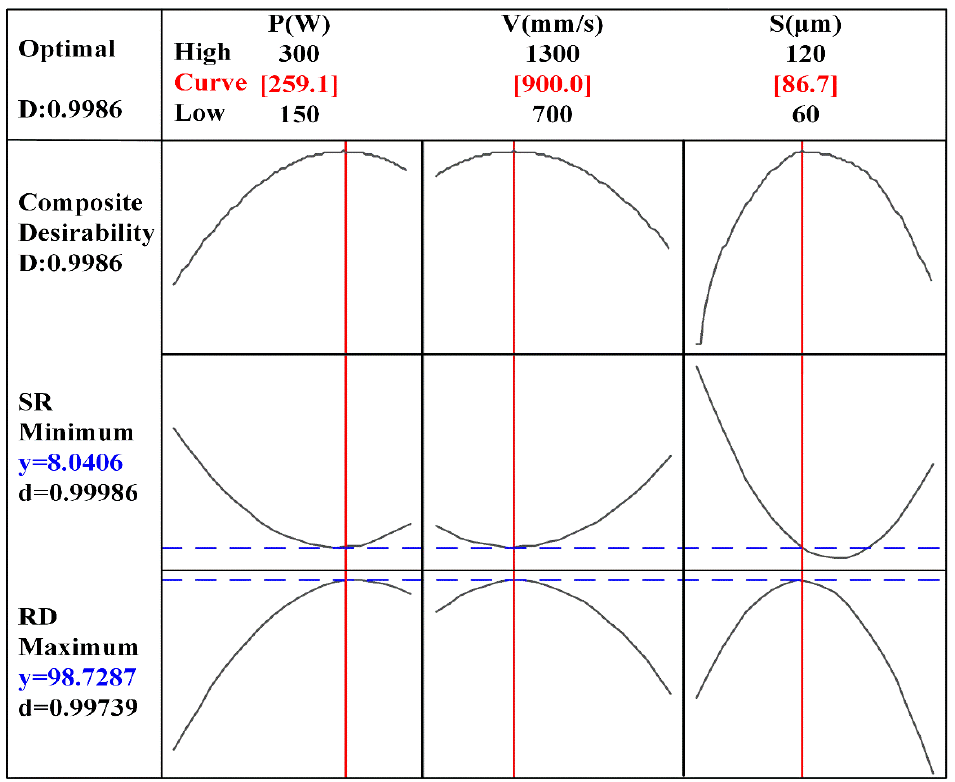
Figure 5. Multi-objective optimization plot for minimizing SR and maximizing RD.